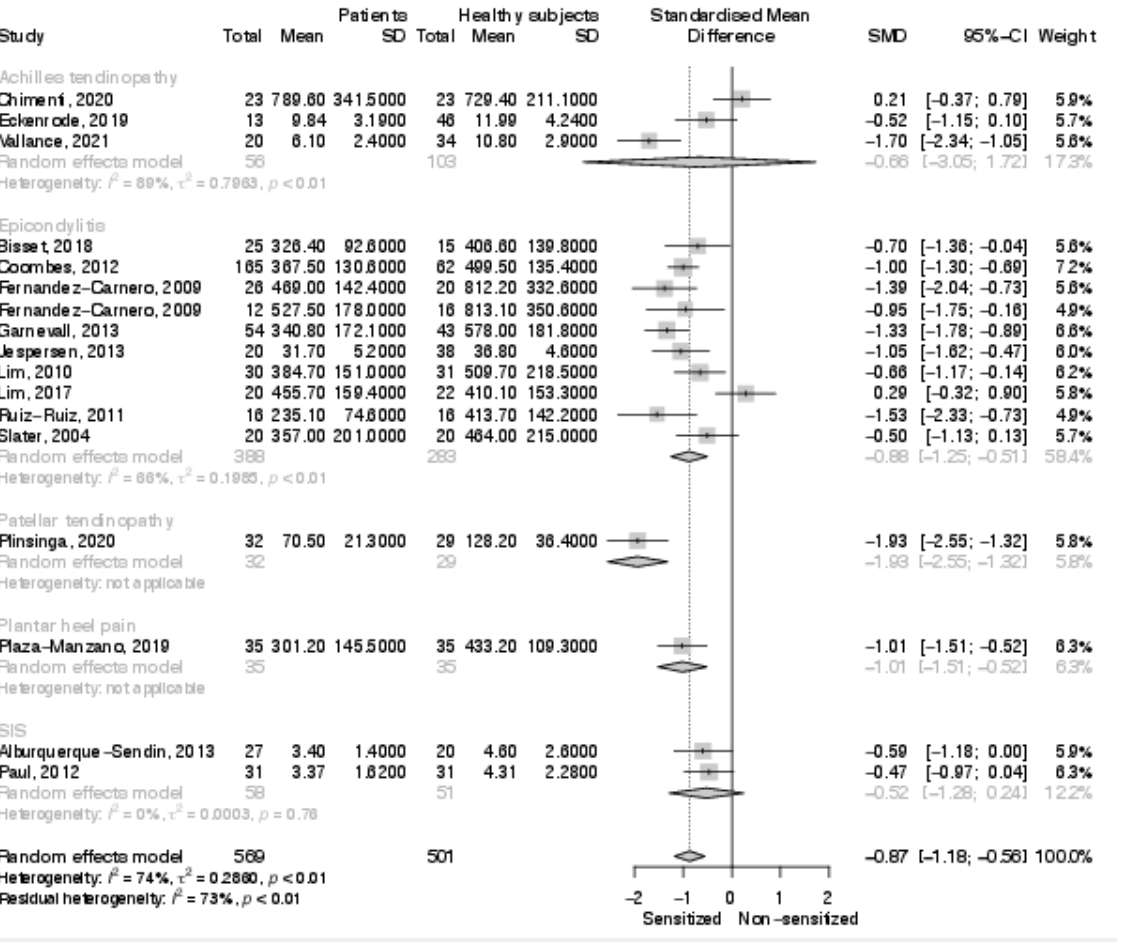
Figure 4. Results of the meta-analysis on contralateral pressure pain thresholds.